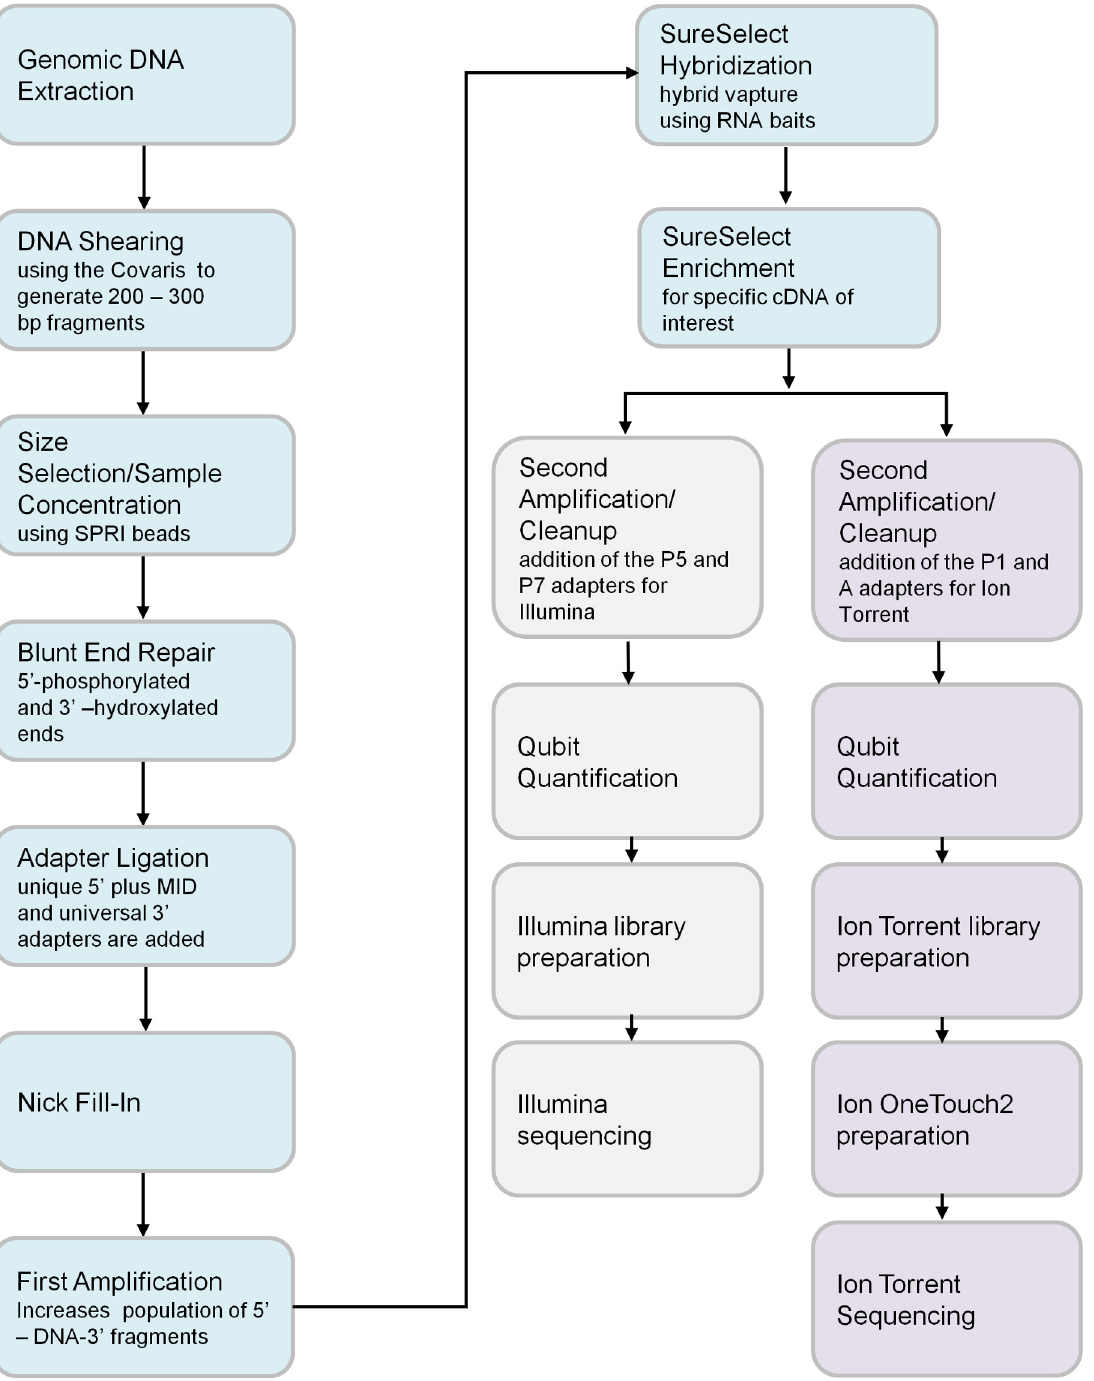
Fig 1. Schematic of the work flow for the next-generation sequencing (NGS) BRCA1/ BRCA2 assay using both the MiSeq and the Personal Gene Machine (PGM) platforms. For the MiSeq platform, variant calling was performed initially with the vendor-supplied MiSeq Reporter software and then with the Quest Sequencing Analysis Pipeline (QSAP). For the PGM platform, the vendor-supplied Torrent Suite variant-calling software was used.